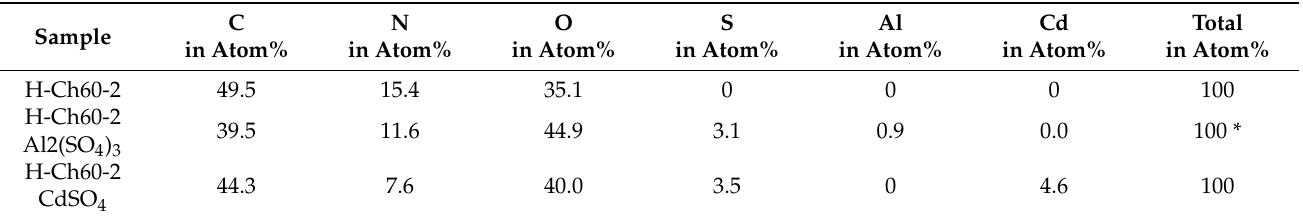
Table 5. Elemental distribution in the atom% measured by SEM-EDX from pure H-Ch60-2, and H-Ch60-2 after adsorption experiments with Al 2 (SO 4 ) 3 (c 0 = 370 mg/L Al 3+ ) and CdSO 4 (c 0 = 800 mg/L Cd 2+ ) solutions, respectively. The corresponding EDX spectra can be found in Figures S18 and